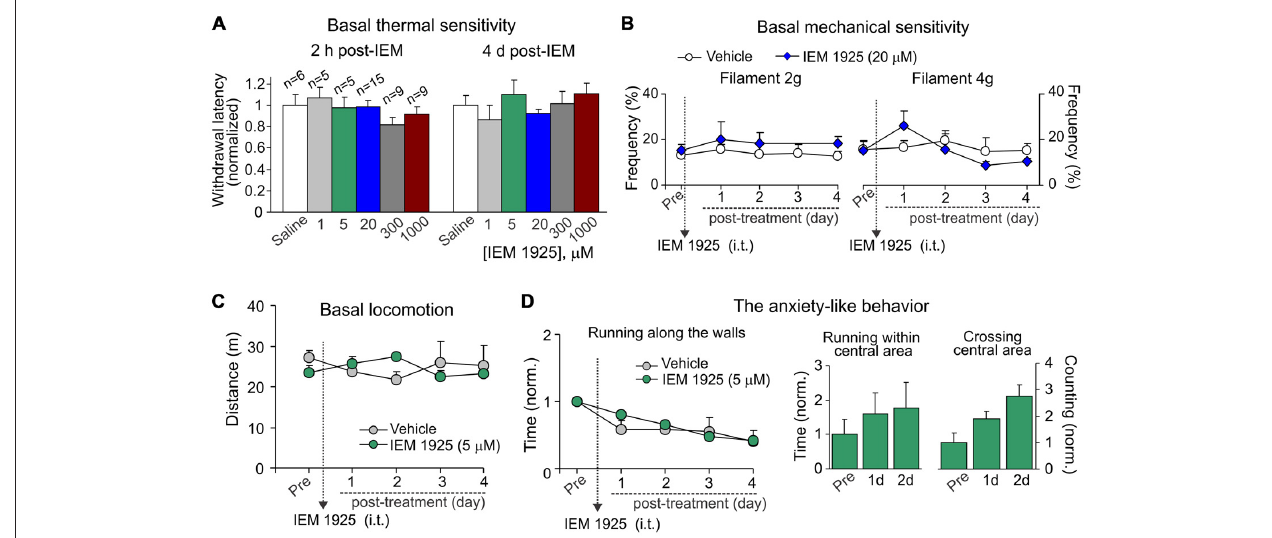
FIGURE 7 | IEM-1925 does not give rise to detectable side effects. (A) The Hargreaves test demonstrates neither acute nor delayed changes of thermal peripheral sensitivity in rats after treatment with dicationic compound IEM-1925 at different concentrations. Data are expressed as the mean paw withdrawal latencies normalized to the correspondent time-point in the saline-treated group. (B) The von Frey behavioral test shows no changes in the mechanical peripheral sensitivity in response to the 2 g (left graph) and 4 g (right graph) von Frey monofilaments in rats treated with 20 µ M IEM-1925. Results are presented as mean ± SEM. (C,D) The open-field test shows no changes in animal locomotion (C) and no rise in the anxiety-like behavior (D) following treatment with 5 µ M IEM-1925. Assessment of the anxiety-like behavior was similar as in Figure 4D ; results are presented as mean values normalized to the correspondent time-point prior to the treatment (Pre) for all parameters